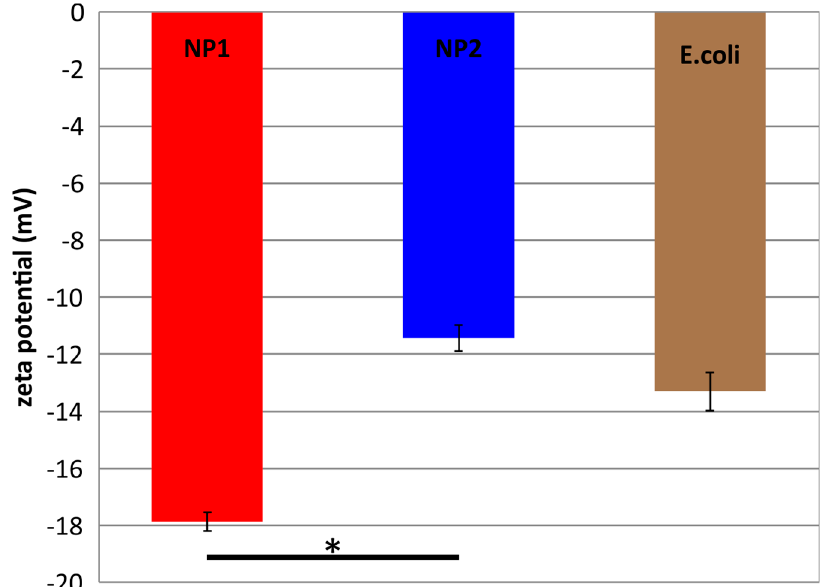
Figure 4. Zeta potential values of nanoparticle dispersion variations NP1 and NP2 with a concentration of 75 μ g/mL. The difference between NP1 and NP2 is statistically significant, as shown by an asterisk ( p < 0.05).